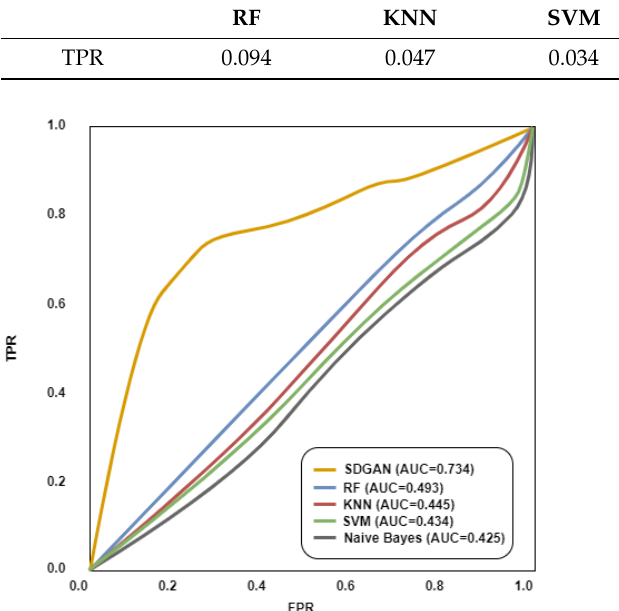
Table 9. TPRs of ML-based DDoS detections on unseen adversarial DDoS attacks.